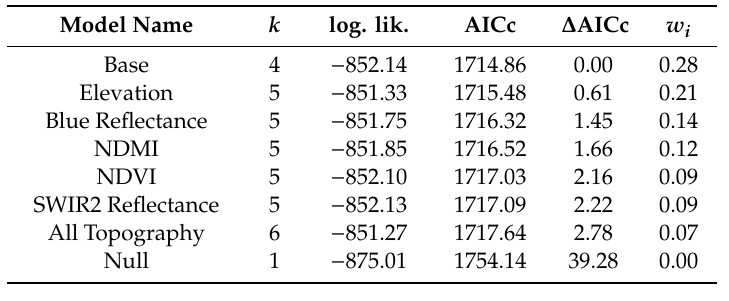
Table 6. Ranking of candidate models used to predict lichen abundance (biomass; kg / ha) as a function of forest structure, topographic and remote sensing attributes (Table 3). Models with a lower Akaike Information Criterion score (AICc) better describe the data. k = number of fixed e ff ects ( + 1 for intercept) and w i = Akaike weight. SWIR2 = short-wave infrared reflectance, NDVI = normalized di ff erence vegetation index, NDMI = normalized di ff erence moisture index (Appendix C).